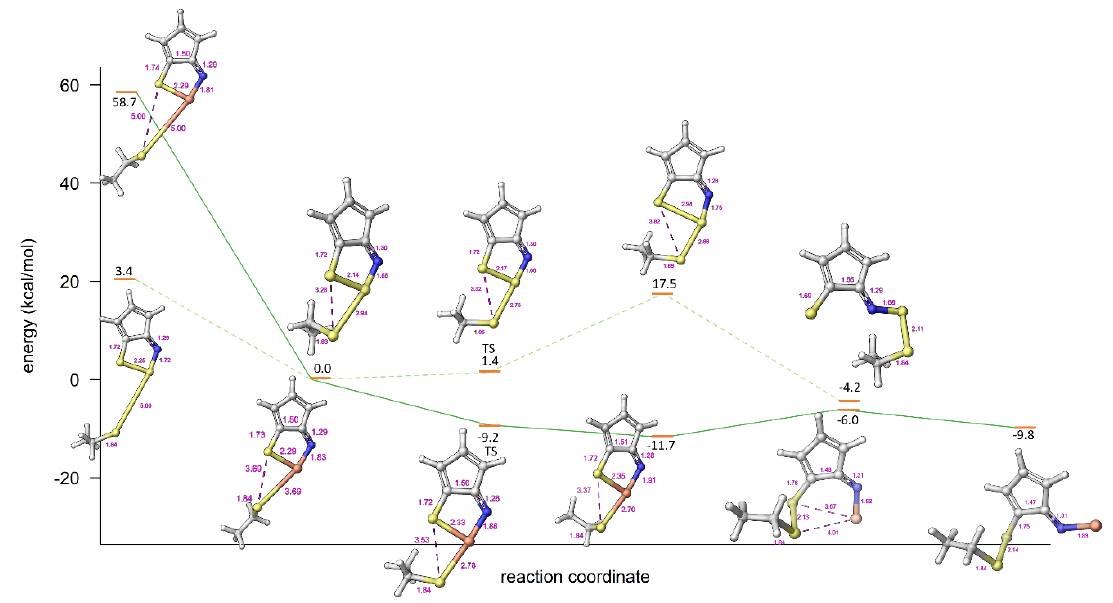
Figure 5. Advanced Transition State Modelling Investigation: Estimated relative reaction energy diagram for the ring opening calculated point wise using model compounds and B3LYP/cc-PVTZ(-F) level of theory. The dashed line shows the relative energetics for 1,2,3-dithiazoles, 10a type compounds and continuous green line shows reaction path for corresponding 1,2,3-thiaselenazoles, 11a selenium derivatives. Stages of the reaction are from left to right: isolated reactant complex, reactant complex, transition state (merged as TS) and theoretical products. Selected bond distances are shown using numbers in magenta color.